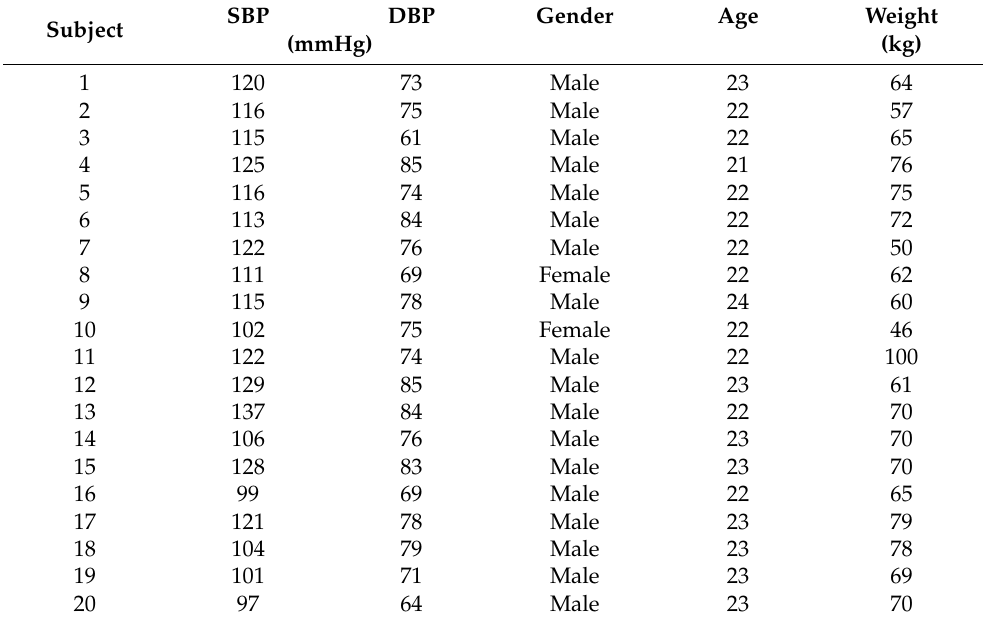
Table 1. BP information for the 20